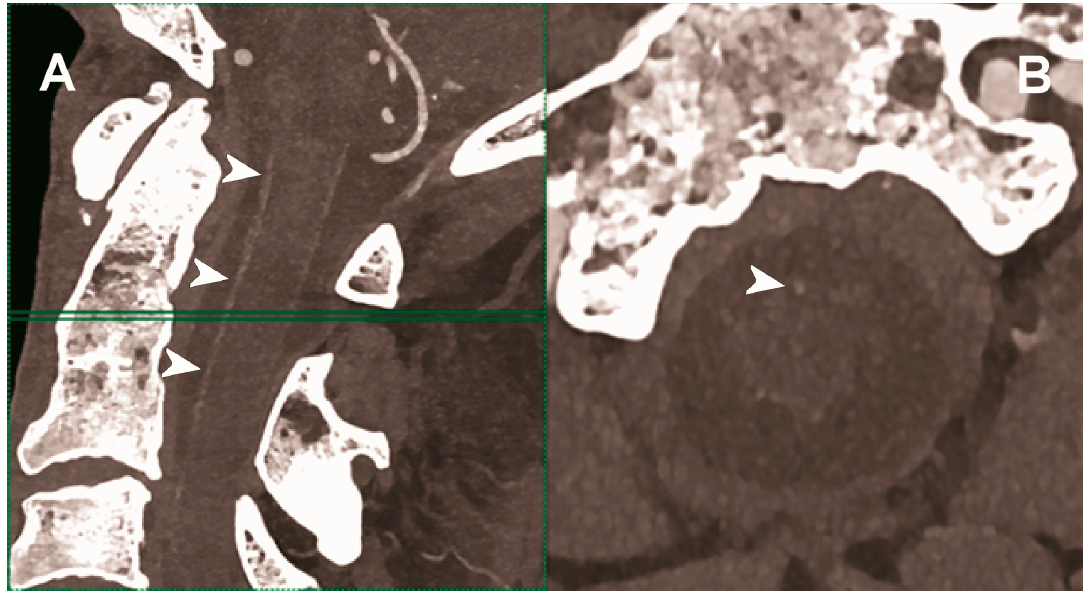
Figure 5. Carotid CT angiography using photon-counting computed tomography. The figure shows advanced MIP reconstructions of a intracervical artery tree derived from a photo-counting CT (Scanner: NAEOTOM Alpha, Siemens) acquisition. In ( A ) a sagittal median view of the cervical region showing the course of the anterior spinal artery (normally not visible) in the ventral portion of the rachidial channel (arrowheads). In ( B ) the axial image at the level of the green plane showed on the left panel with the axial view of the anterior spinal artery